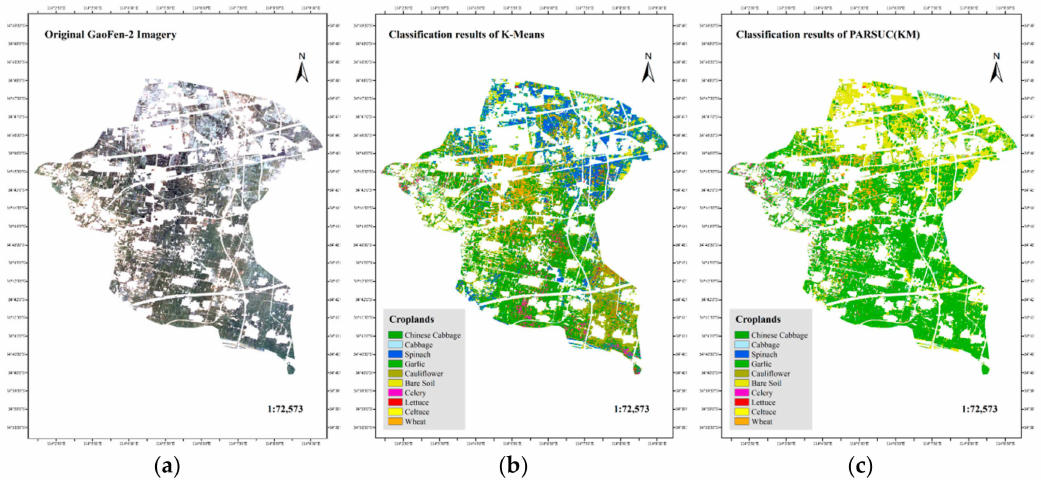
Figure 8. Original GaoFen-2 imagery ( a ), classification results of PARSUC(KM) ( b ) and K-means ( c ). A total of 179 in situ measured cropland samples on 20 March, 2018 were performed to validate the classification results by means of Kappa coe ffi cient and overall accuracy with a confused matrix. than those of K-means results (47.2569%, 0.4126).